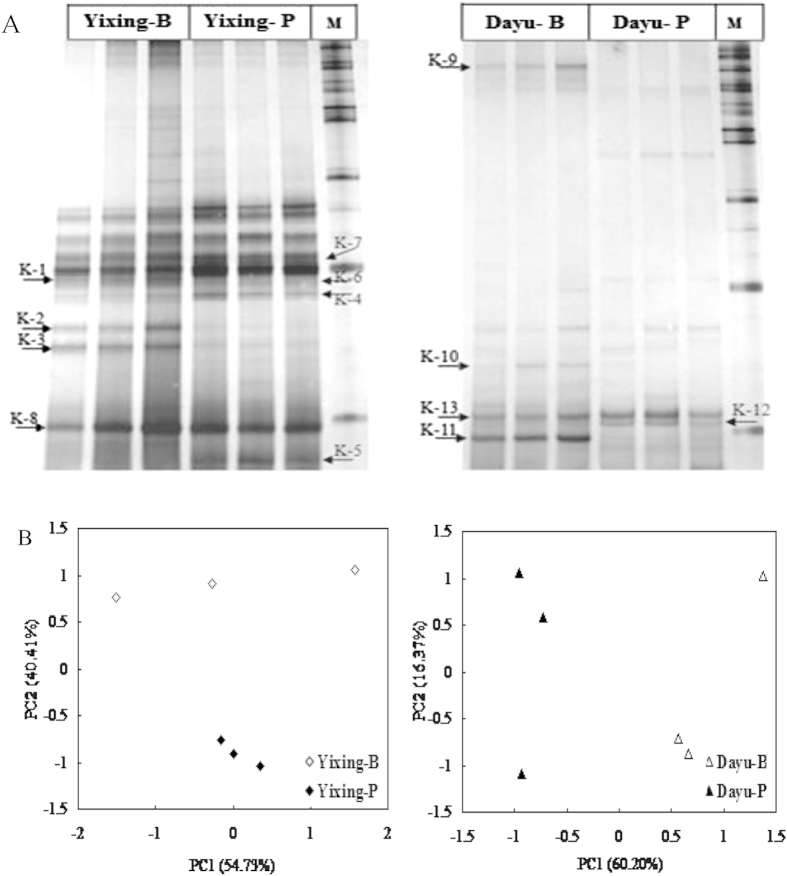
DGGE profiles (A) and principal component analysis (B) of nirK gene fragment from the background and polluted soils in Yixing and Dayu. M: 100 bp Marker. Arrows indicate the excised bands (K1–K13) for sequencing. Similar symbols in PCA plot indicate the triplicate samples.